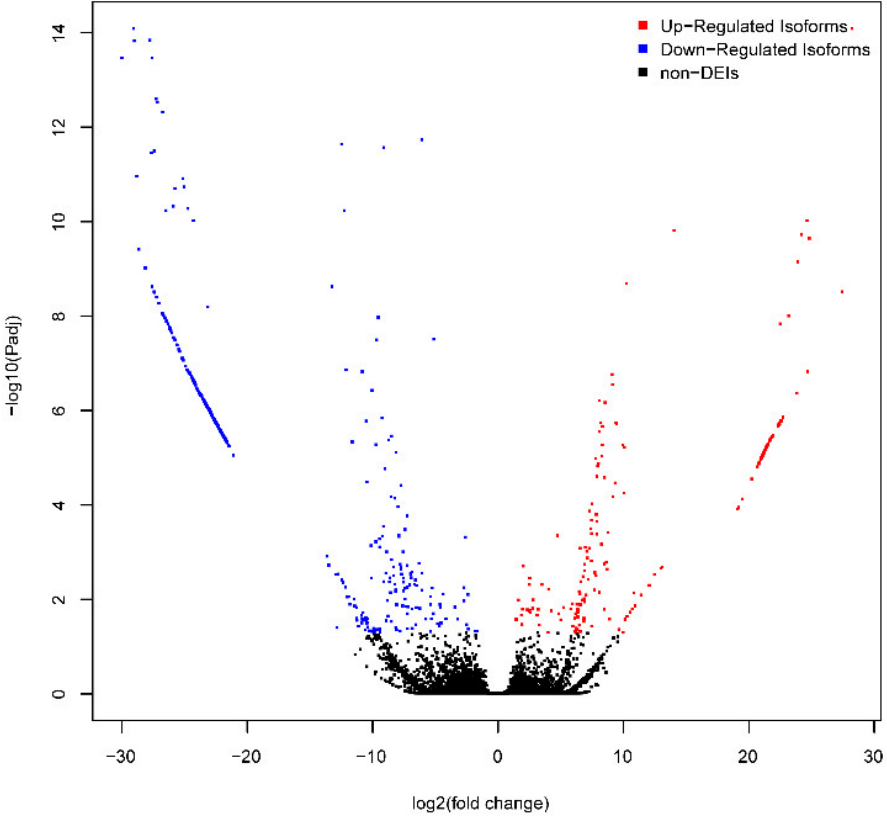
Figure 3. Volcano plot of differentially expressed isoforms (DEIs). X-axis denotes log2 (fold change). Y-axis denotes −log10 (adjusted p value). Red dots denote the up-regulated isoforms. Blue dots denote down-regulated isoforms.